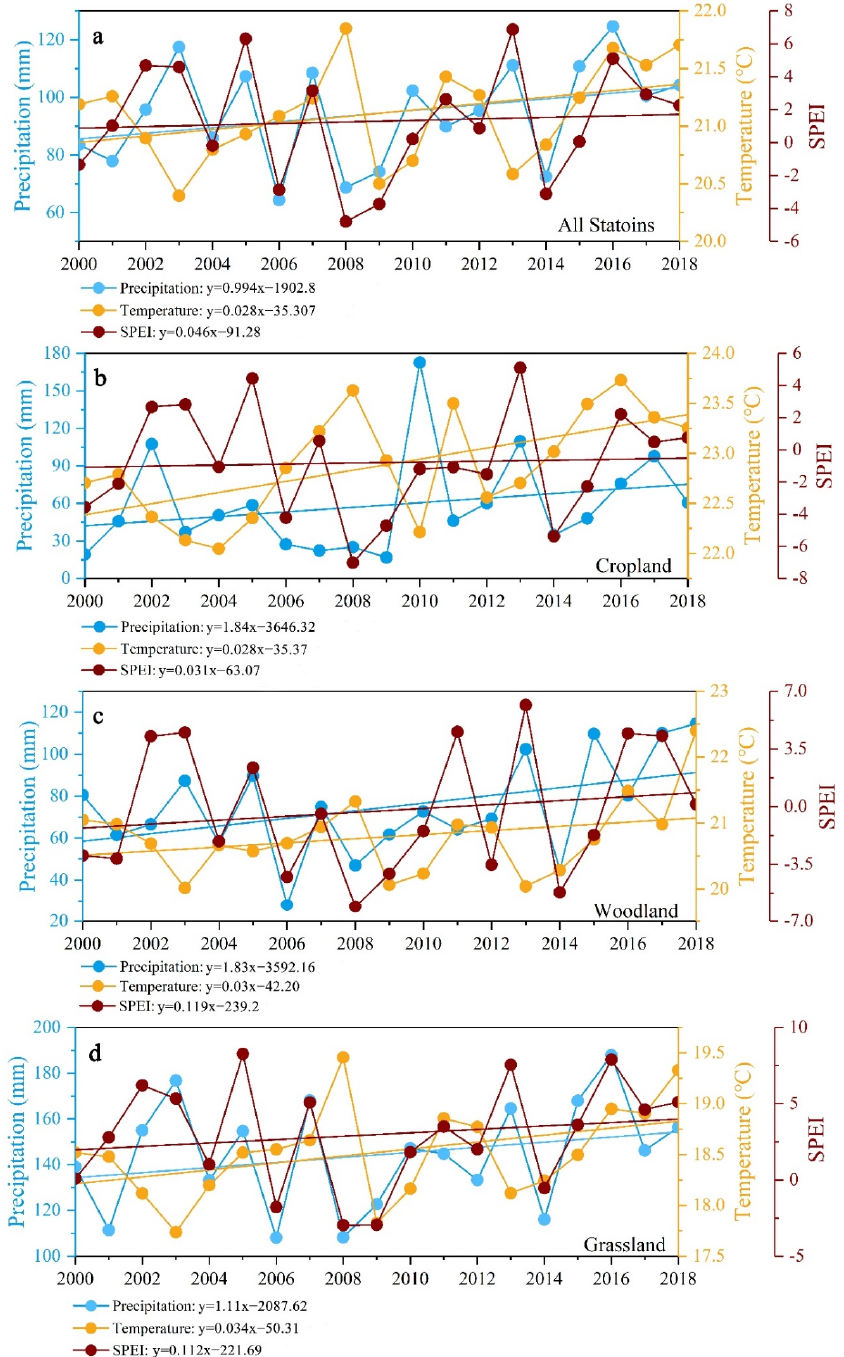
Figure 5. Long-term growing season (May-September) total precipitation, and average mean temperature and SPEI, spatially aggregated over ( a ) Xinjiang, ( b ) cropland, ( c ) woodland and ( d ) grassland. Comparison was performed based on average values during growing season in the 42 meteorological stations over 2000 − 2018. The regression lines are drawn for every climate factor and the label shows the corresponding regression equation.